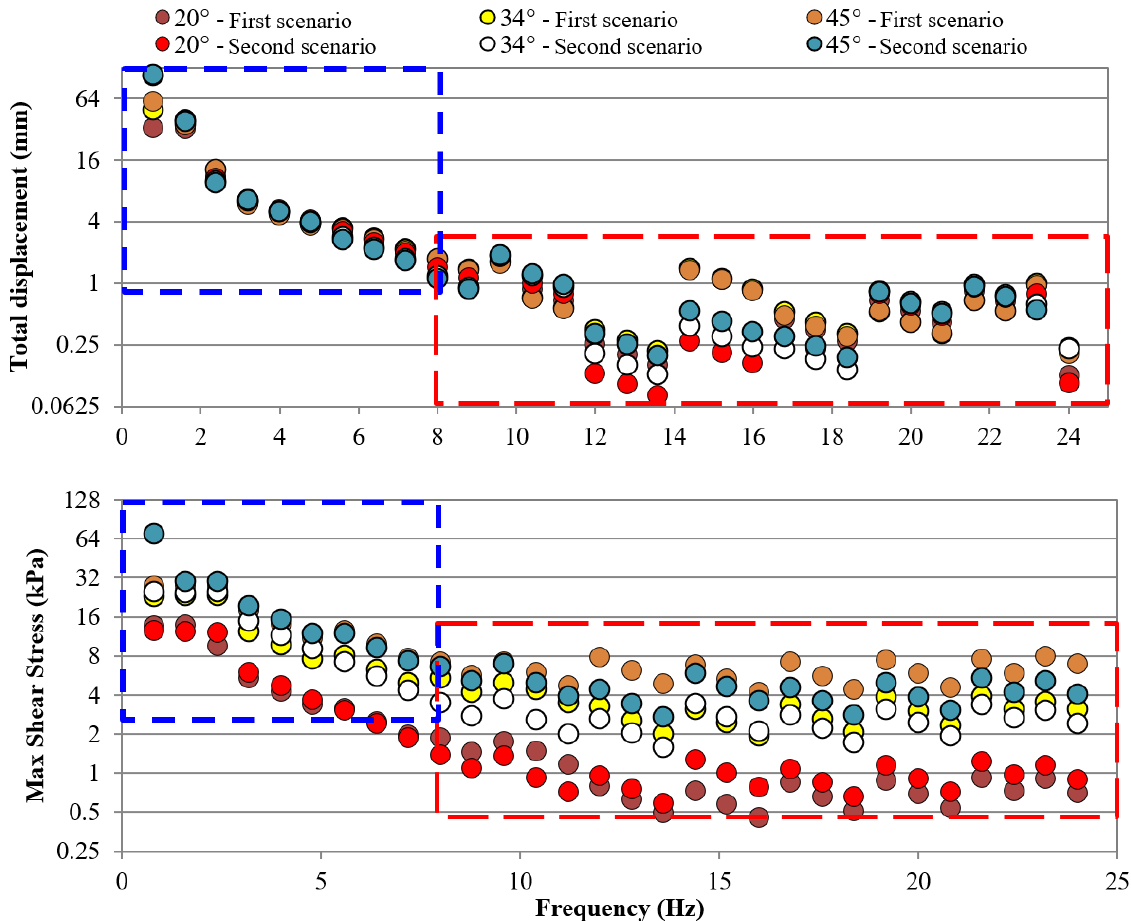
Figure 9: The maximum calculated value of total displacement (top) and shear stress (bottom) at the base of the slope for all 180